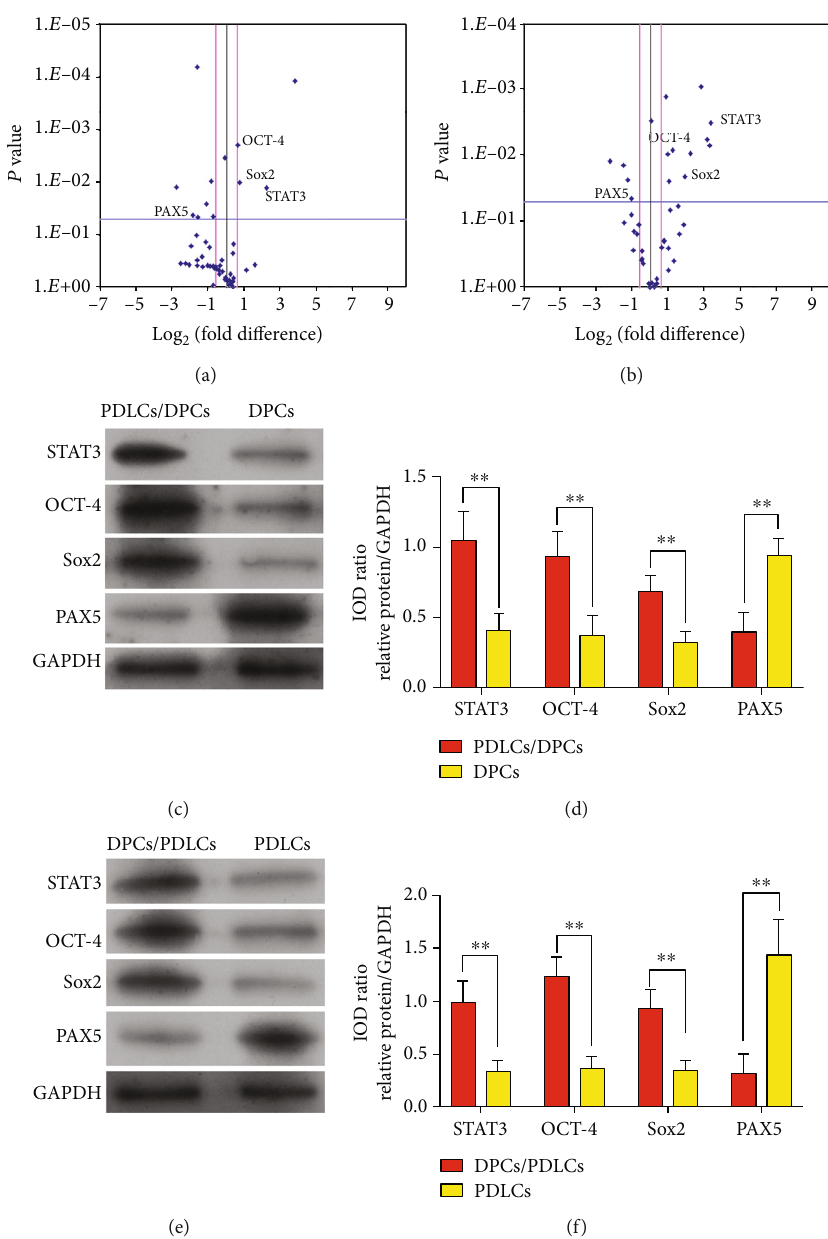
Figure 4: Di ff erentially expressed genes in DPCs and PDLCs with indirect coculture. The x -axis (a log transformation plot of the fold di ff erence) and the y -axis ( P value) indicate the di ff erential expression of each gene in the indirect coculture and control groups of DPCs (a) and PDLCs (b). The pink lines indicate a 3-fold up- or downregulation of gene expression. The blue line indicates the threshold for the P value ( P < 0 : 05 ) of the t -test. In the indirect coculture systems, four genes ( ZFPM2 , STAT3 , SOX2 , and OCT-4 ) were signi fi cantly upregulated, and seven genes ( EGR3 , PAX5 , PCNA , STAT1 , RUNX1 , FGF1 , and NOTCH2 ) were signi fi cantly downregulated in the indirect cocultured DPCs. Meanwhile, ten genes ( STAT3 , HOXC10 , HOXA9 , EZH2 , ESR1 , SOX2 , OCT-4 , DLX2 , PPARG , and KLF4 ) were signi fi cantly upregulated, whereas four genes ( PAX1 , NANOG , HOXA7 , and PAX5 ) were signi fi cantly downregulated in the indirect cocultured PDLCs. Western blot analyses showed that the levels of STAT3, OCT-4, and SOX2 protein expression were strongly upregulated and PAX5 expression was downregulated in DPCs (c, d) and PDLCs (e, f) after indirect